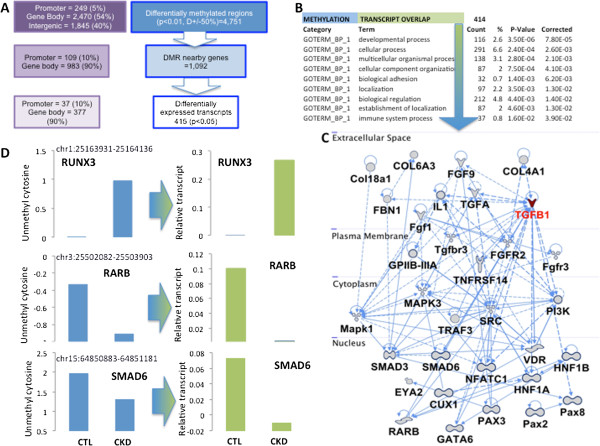
Differentially methylated regions correlate with transcript changes. (A) The 4,751 DMRs mapped to 1,092 unique genes that were present in the Affymetrix arrays. There were 415 transcripts that showed differences both in their methylation status and their expression in CKD samples. The RefSeq-based locations of the DMRs are also shown. While most differentially methylated regions localize to gene body regions, they also show correlation with the expression of many of those genes. Not only are the 415 transcripts differentially expressed, they also show differences in their cytosine methylation profiles as well. (B) DAVID-based gene ontology annotation of the 415 transcripts. (C) Network chart of the genes that are both differentially expressed and methylated). (D) Methylation and gene expression level of key molecules (RUNX3, RARB, SMAD6) identified by the network analysis in control (CTL) and CKD samples.